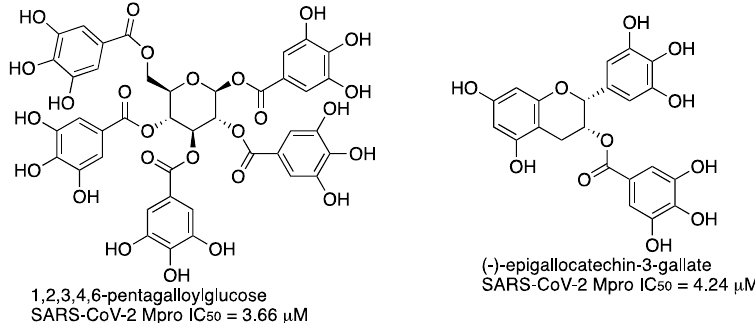
Figure 17. Natural products pentagalloyl glucose (PGG) and (-)-epigallocatechin-3-gallate (EGCG) as SARS-CoV-2 Mpro